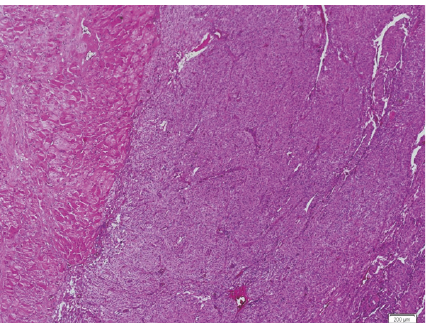
Figure 2: Adrenal gland, pheochromocytoma, and diffuse growth pattern with high cellularity. H&E ×